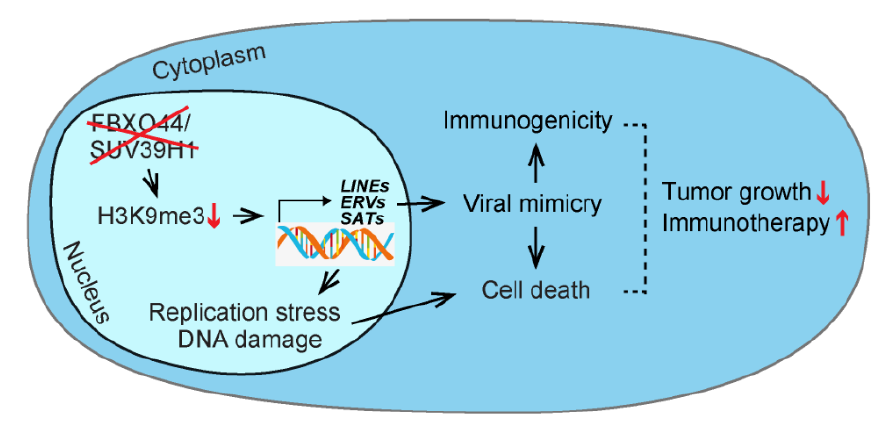
FIGURE 1: Graphical representa- tion of this study. FBXO44/SUV39H1 targeting acti- vates REs that elicit DNA replica- tion stress and viral mimicry in cancer cells, leading to tumor growth arrest and enhanced im- munotherapy